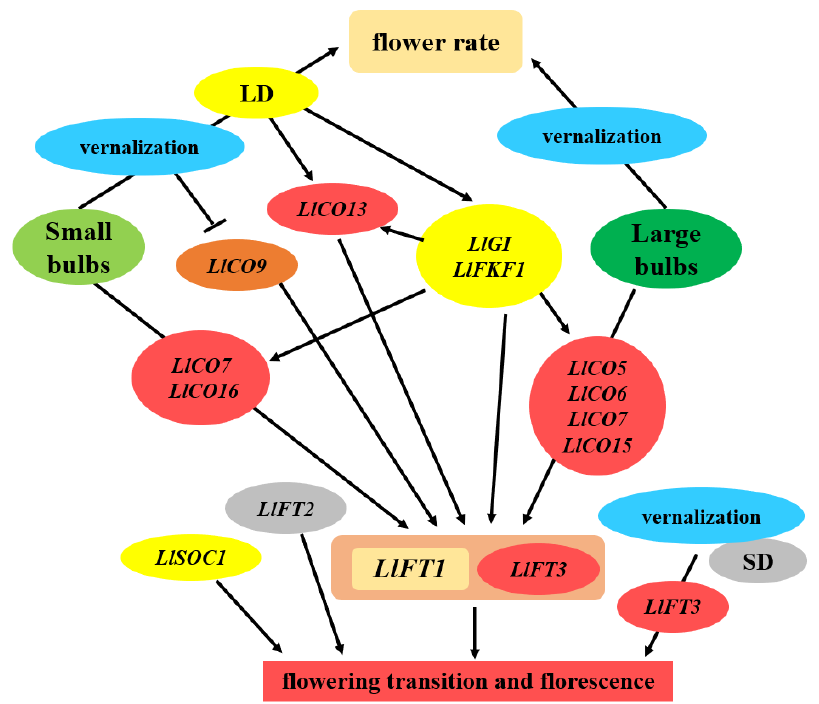
Figure 5. Photoperiod related key gene network in small and large bulbs of Lilium longiflorum after planting. Notes: These abbreviations are the same as above. Arrows indicate a promoting, T-ends indicate an inhibiting interaction.